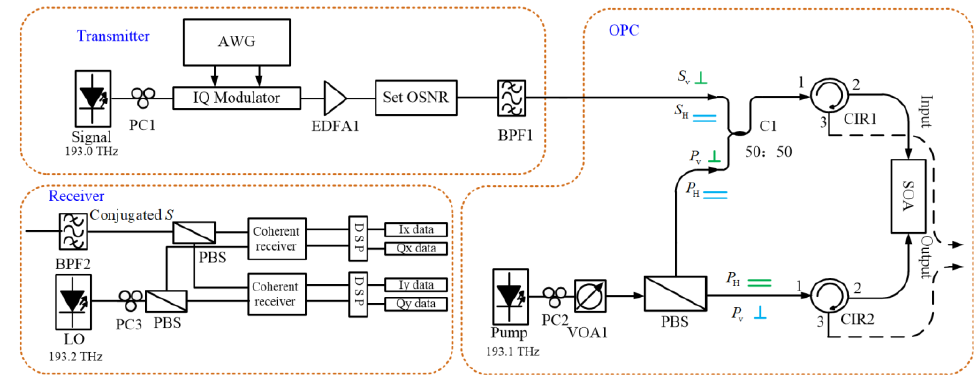
Figure 2. Simulation setup of the nonlinear bidirectional SOA-based OPC